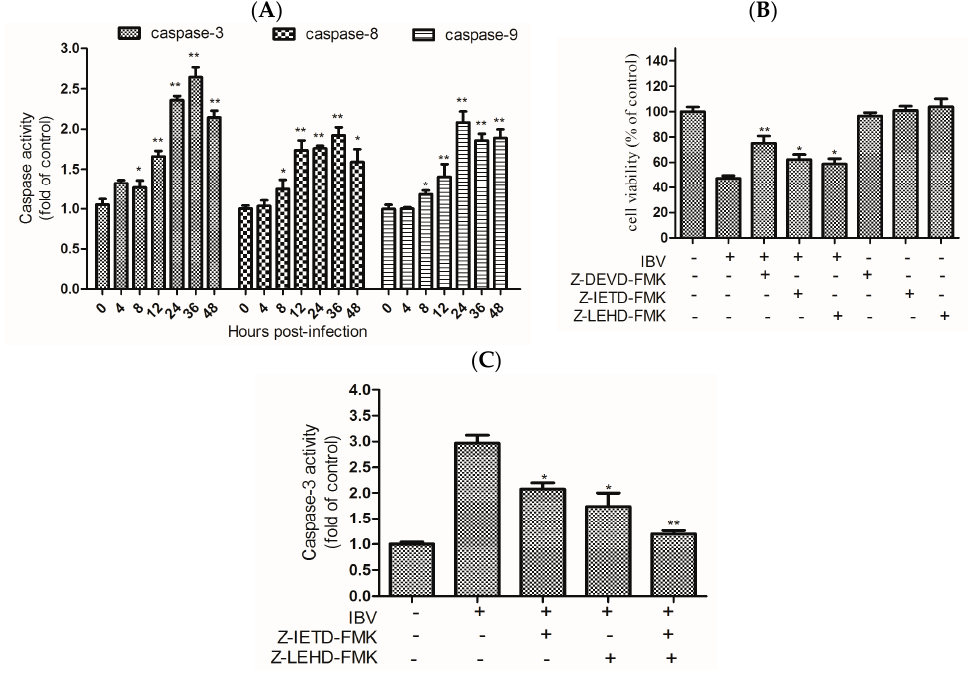
Figure 3. Effects of IBV Beaudette infection on caspases in HD11 cells. ( A ) The activity of caspases in IBV Beaudette-infected cells. The caspases -3, -8 and -9 activity in HD11 cells infected with IBV at 10 MOI at the designed times were determined. The data are shown as the mean ± SEM, * p < 0.05, ** p < 0.01 versus the control group (0 h). ( B ) Role of caspase inhibitors in cell viability. Cell viability was determined by CCK-8 assay: 20 μ M of each caspase inhibitor was utilized to pre-treat cells for 2 h. Then, the treated and untreated cells were both infected with IBV Beaudette at an 10 MOI for 36 h. The data are shown as the mean ± SEM, * p < 0.05, ** p < 0.01 versus IBV infection alone. ( C ) The effect of initiator caspase-8 or -9 on the activation of caspase-3: 20 μ M of each caspase inhibitor was utilized to pretreat cells for 2 h. Then, the treated and untreated cells were infected with IBV at 10 MOI for 36 h. Caspase-3 activity was detected using a colorimetric assay kit. Data are shown as the mean ± SEM, * p < 0.05, ** p < 0.01 versus virus infection alone.